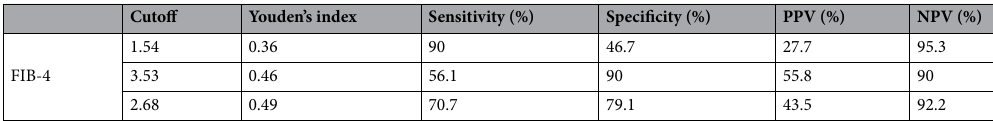
Table 3. Determining new cutoff value for FIB-4 in diagnosing advanced fibrosis. Advanced fibrosis was defined as liver stiffness greater than 4 kPa. PPV positive predictive value, NPV negative predictive value.